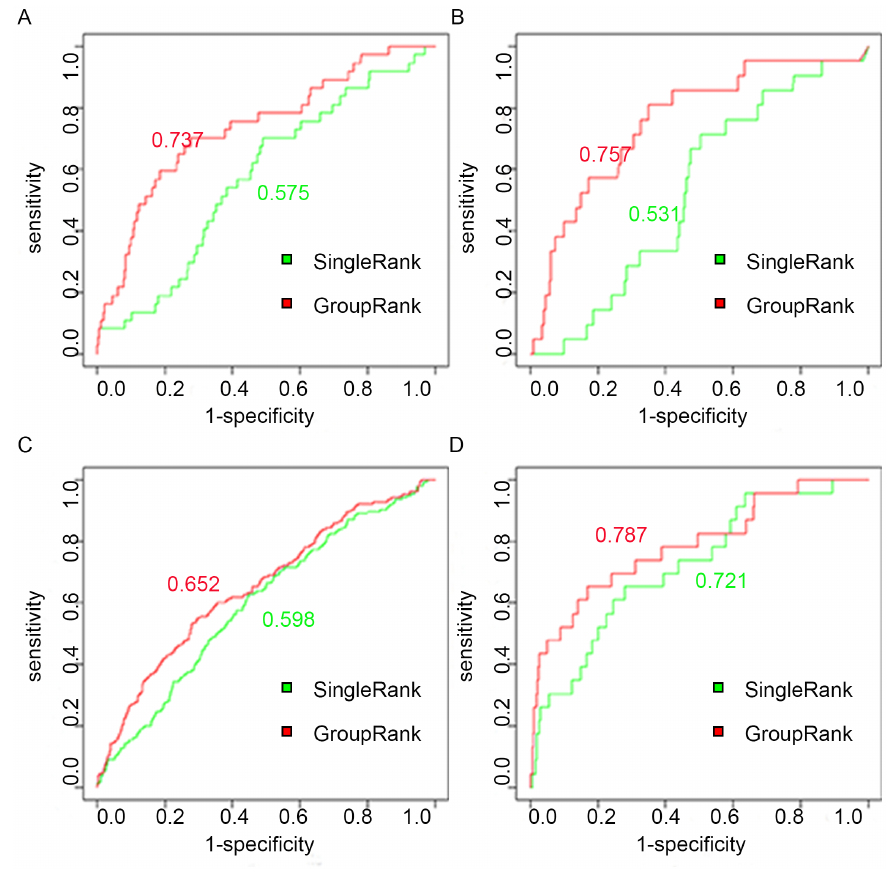
Figure 1. Mean rank ratio of GroupRank using different distance thresholds. The gene groups in GroupRank are partitioned based on a distance threshold with a gradient from 0.1 to 0.9. From A to D, the cancer types are lung cancer, kidney cancer, leukemia and breast cancer.